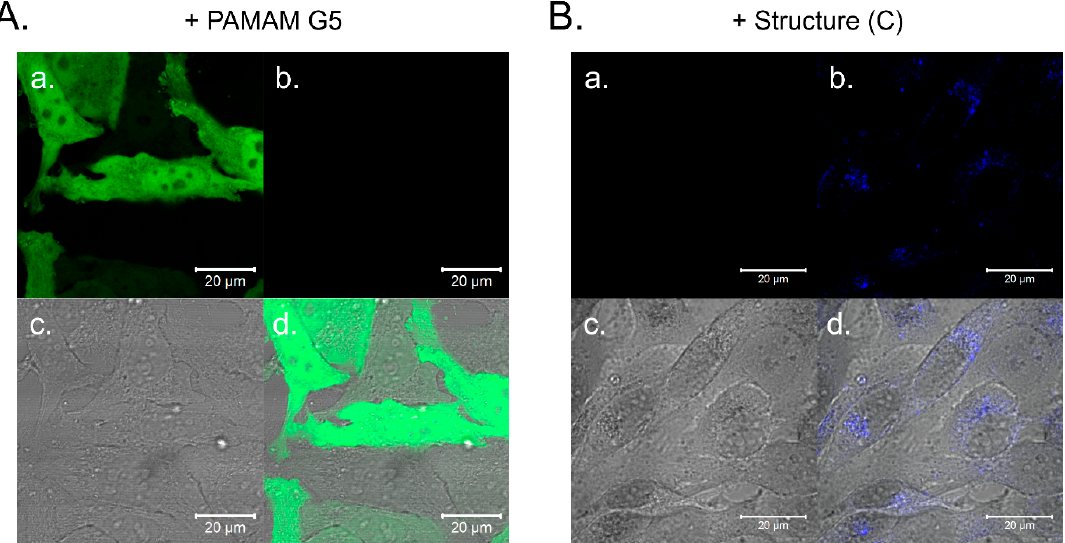
Figure 6. Representative confocal images of HeLa cells transfected using PAMAM G5 ( A ) and PAMAM [G5:G3-(TREN)]- N -(4-carbomethoxy) pyrrolidone terminated tecto(dendrimer) (Structure (C)) ( B ). Dendrimers were complexed at 8:1 N/P ratio with expression plasmid encoding TagGFP2, and cells were incubated with this complex for 24 h. Split images represent: a. TagGFP2 fluorescence (green channel), b. nontraditional intrinsic luminescence of the dendrimer (NTIL) (blue channel), c. transmitted light image, d. merge of a., b. and c.